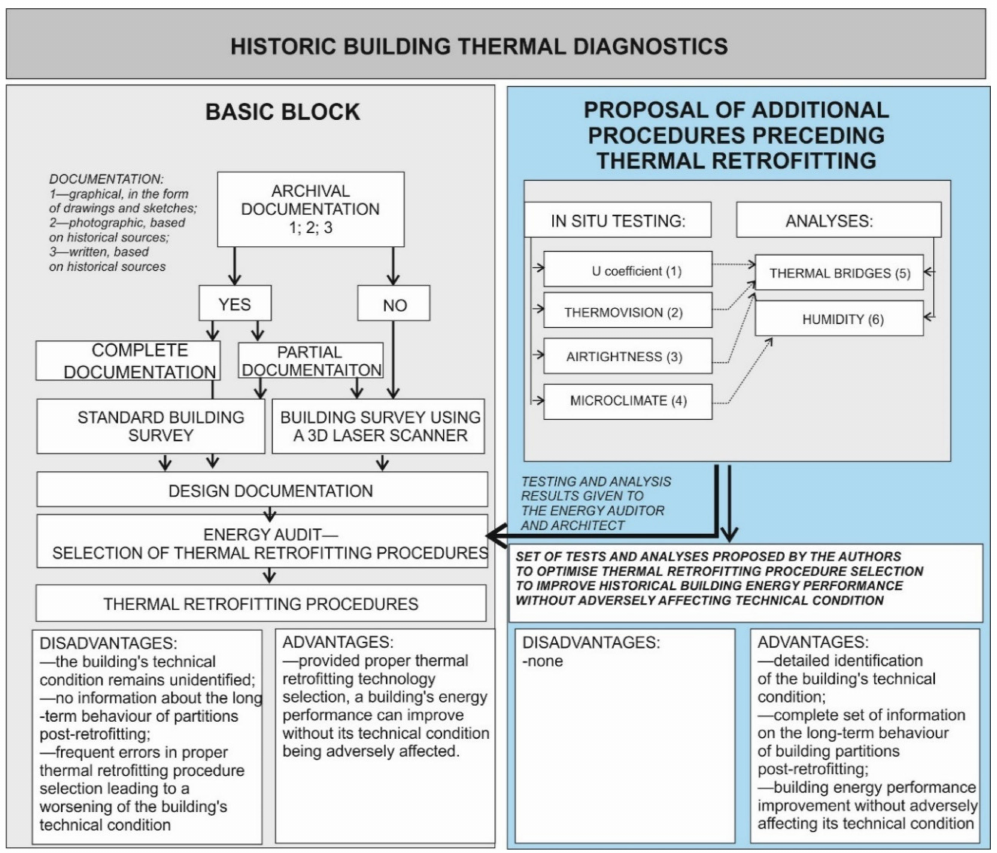
Figure 5. Standard procedure for thermal diagnostics of historic buildings and a new procedure proposed by the